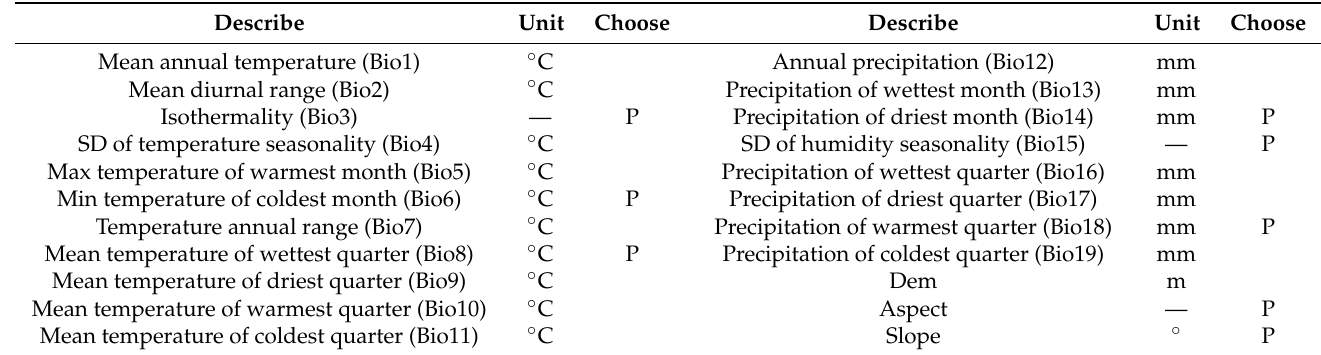
Table 3. Description of climate data